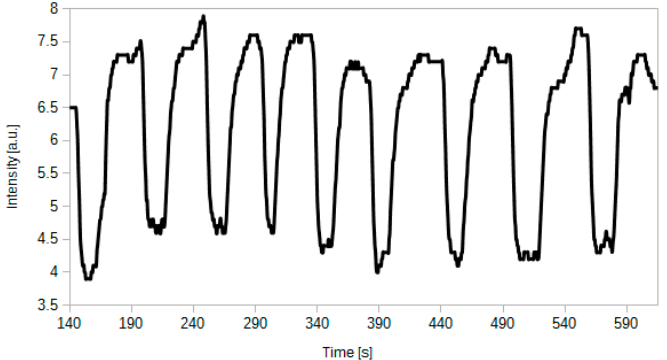
Figure 7. Intensity of the transmitted light for a sensor consecutively exposed to CO 2 and fresh air with CO 2 content below 0.1%.